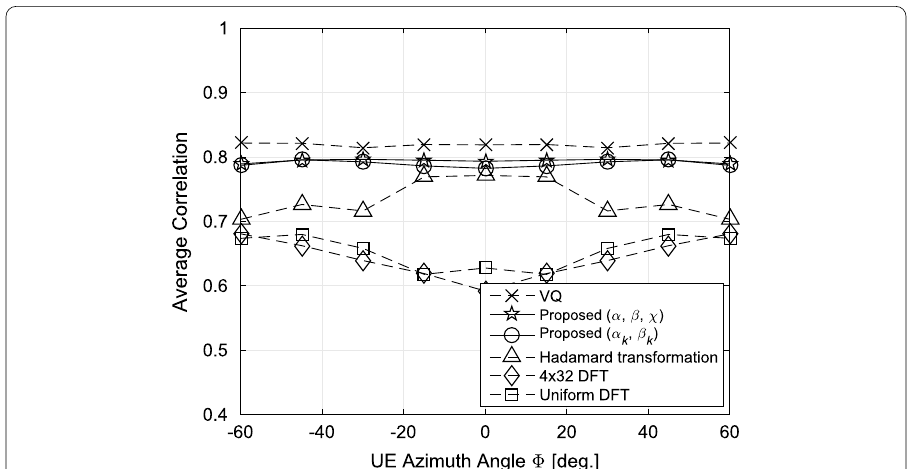
Fig. 11 Location-specific performance of codebooks for the cross-polarized antenna array